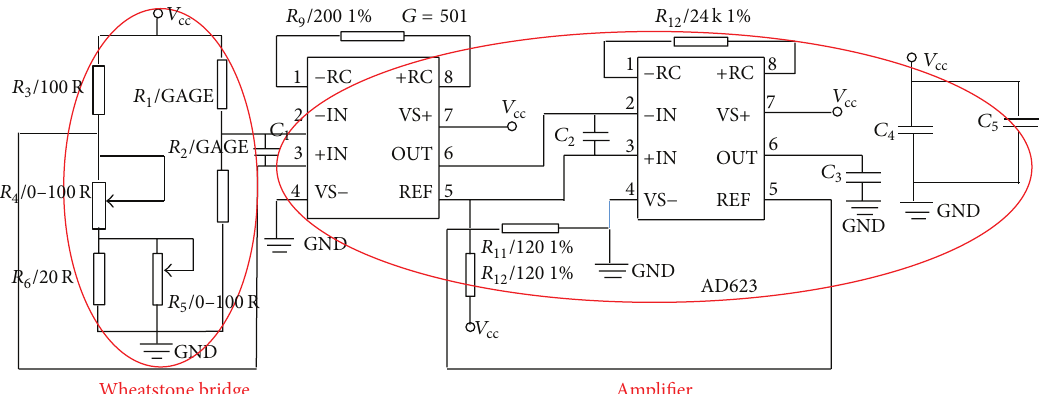
Figure 1: Wireless strain sensor board circuit